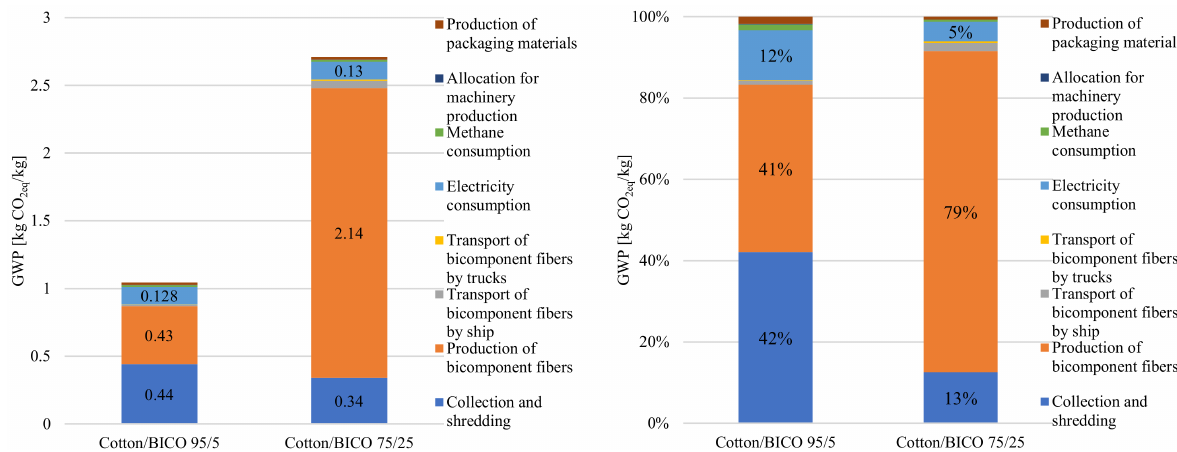
Figure 4. GWP, in kg CO 2 eq per 1 kg of insulation, of the two textile alternatives.